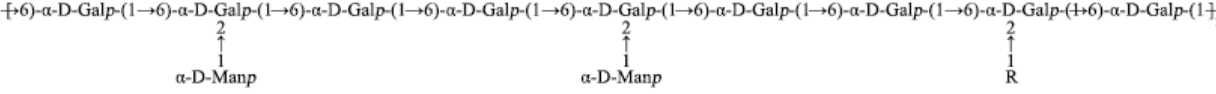
Figure 1. Predicted structure of the PCP-1C repeat unit. (R indicates the following fragments: T- α -D-Manp, T- α -L-Fucp, T- β -D-Glcp, 1,3- α -L-Fucp, 1,6- β -D-Glcp, 1,3- β -D-Glcp, and 1,4- β -D-Glcp res- idues).